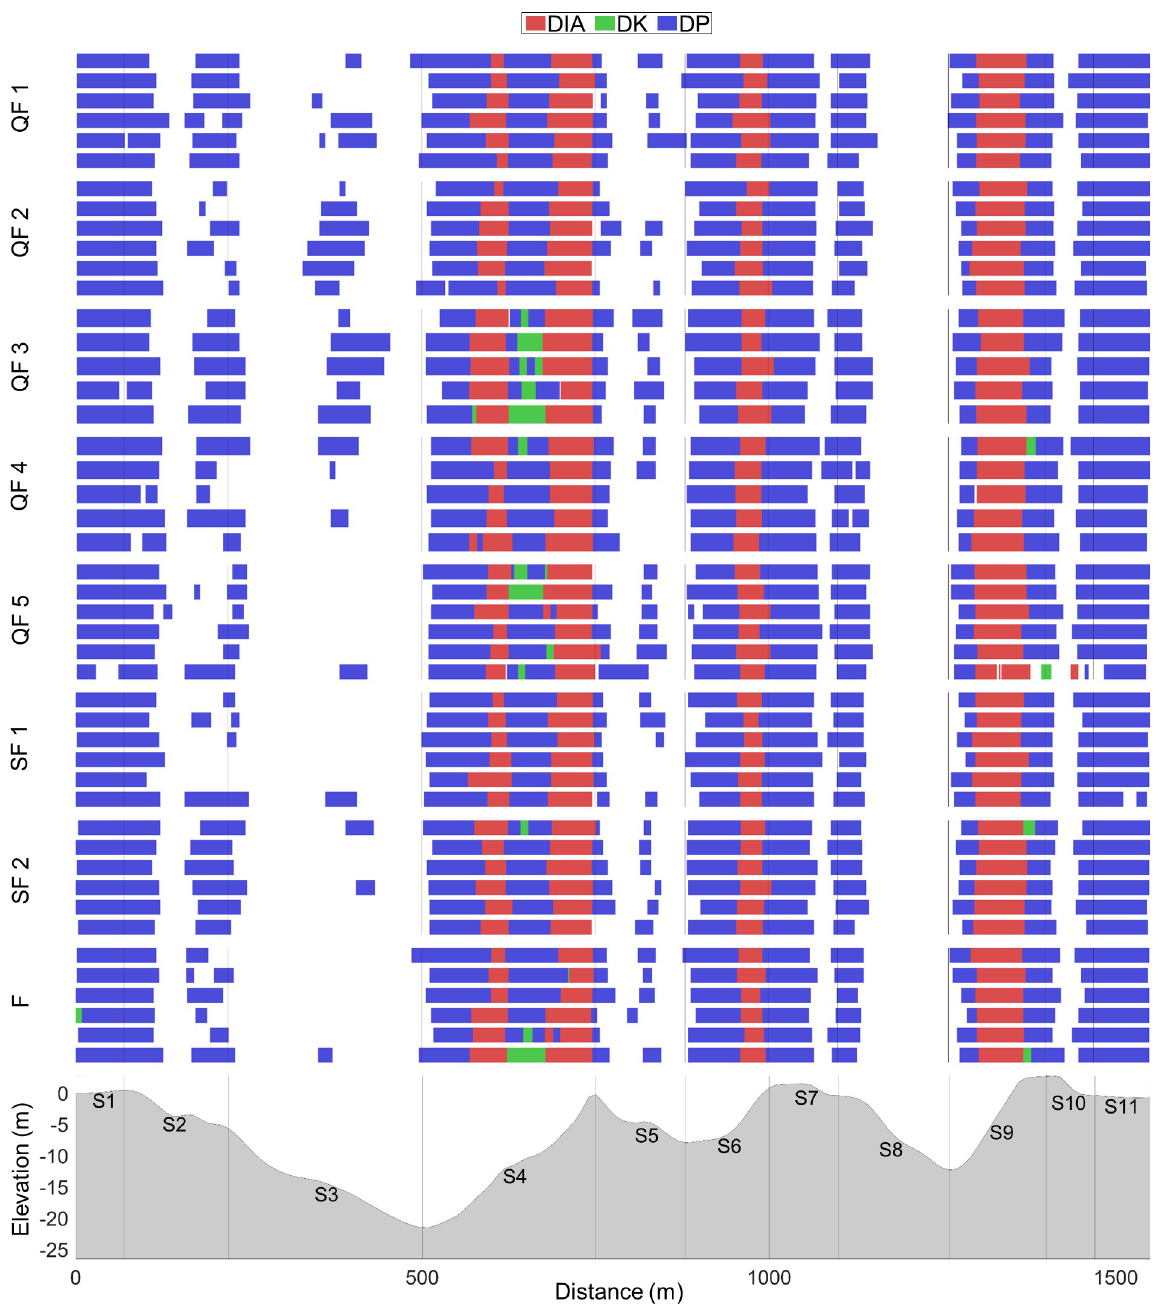
Fig 4. Individual sub-technique selection. The individual use of sub-techniques (diagonal stride [DIA], double poling with a kick [DK], double poling [DP]) and [Other] including tuck and turning techniques) across the racecourse in 11 segments (S1-S11) during the heats of a classical sprint cross-country skiing race for elite male skiers. The skiers are presented according to the order of ranking from top 1 st to bottom 6 th [N = 28].